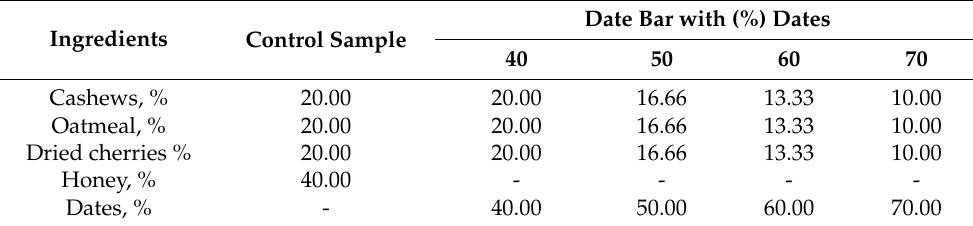
Table 1. Date bar